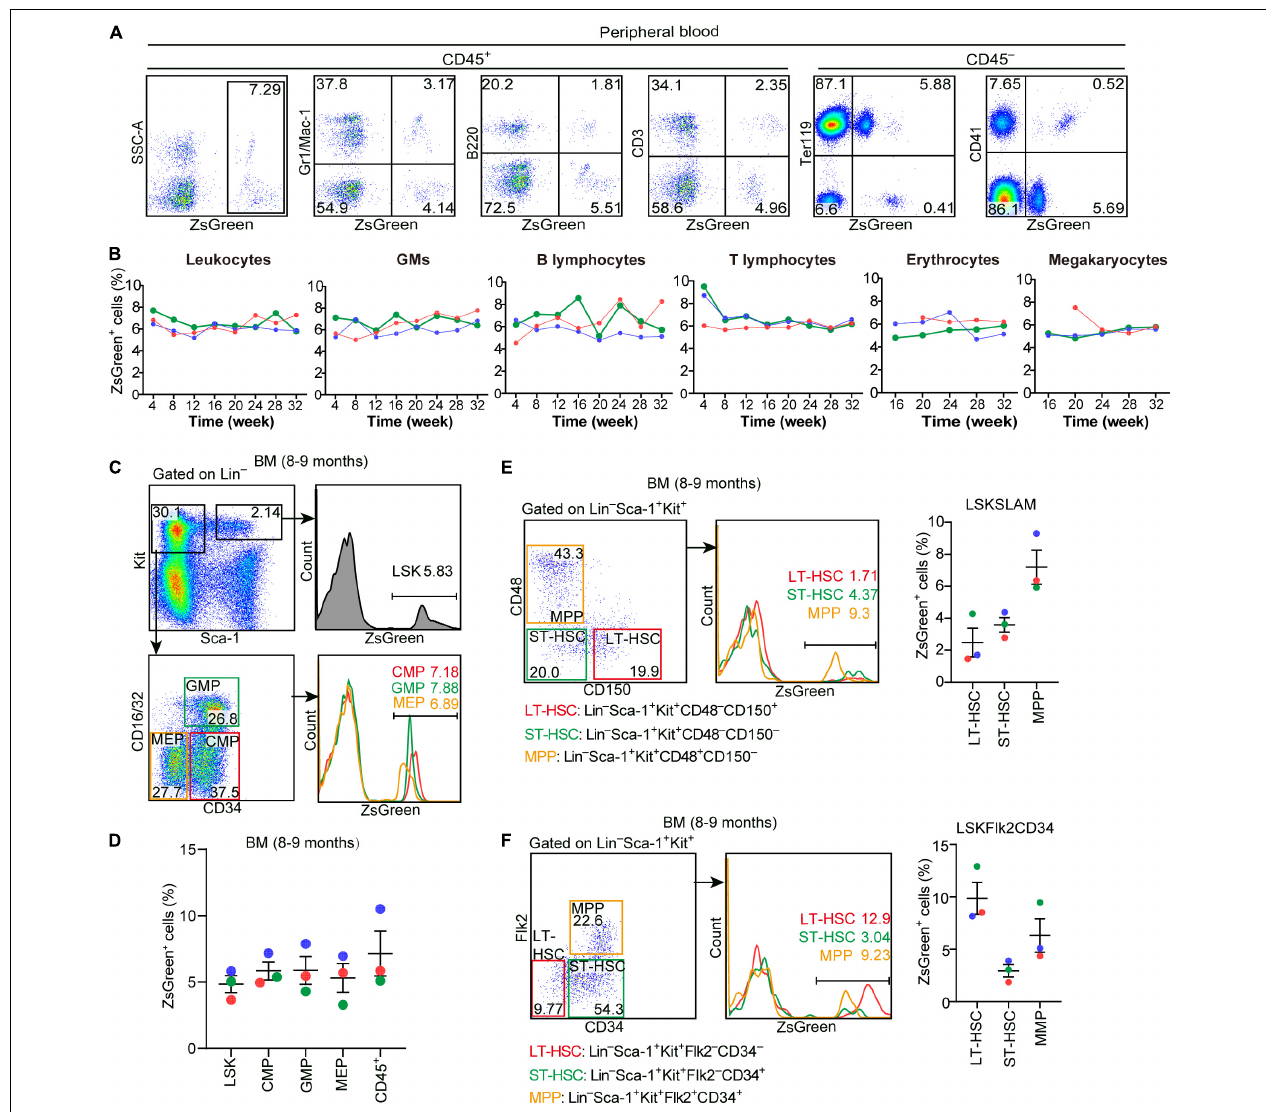
FIGURE 5 | Hlf-labeled early cells contribute to long-term and multi-lineage adult hematopoiesis. (A) Representative FACS plots showing the proportions of Hlf-labeled cells in CD45 + cells and in each hematopoietic lineage in the peripheral blood from a 32-week old Hlf-CreER;ZsGreen mouse with tamoxifen administration at E9.5. (B) Graphs showing the dynamics of the labeling proportions in CD45 + leukocytes, granulocytes/monocytes (GMs), B lymphocytes, T lymphocytes, erythrocytes, and megakaryocytes, respectively, in the peripheral blood of Hlf-CreER;ZsGreen mice at 4–32 weeks old with tamoxifen administration at E9.5. Data are from three individuals represented by different colors. (C) Representative FACS plots showing the proportions of Hlf-labeled cells in LSK (Lin − Sca-1 + Kit + ) cells, CMPs, GMPs, and MEPs in the bone marrow (BM) of 8–9 month-old Hlf-CreER;ZsGreen mice with tamoxifen administration at E9.5. (D) Graph showing the proportions of Hlf-labeled cells in LSK cells, CMPs, GMPs, MEPs, and CD45 + cells in the bone marrow (BM) of 8–9 month-old Hlf-CreER;ZsGreen mice with tamoxifen administration at E9.5. Data are shown as means ± SEM from three independent experiments represented by different colors. CMP, common myeloid progenitor; GMP, granulocyte-monocyte progenitor; MEP, megakaryocyte-erythroid progenitor. (E) Representative FACS plots (left) and graph (right) showing the proportions of Hlf-labeled cells in LT-HSCs, ST-HSCs, and MPPs in the bone marrow (BM) of adult Hlf-CreER;ZsGreen mice with tamoxifen administration at E9.5. LSKSLAM marker combination was used. Data are from three independent experiments represented by different colors. (F) Representative FACS plots (left) and graph (right) showing the proportions of Hlf-labeled cells in LT-HSCs, ST-HSCs, and MPPs in the bone marrow (BM) of